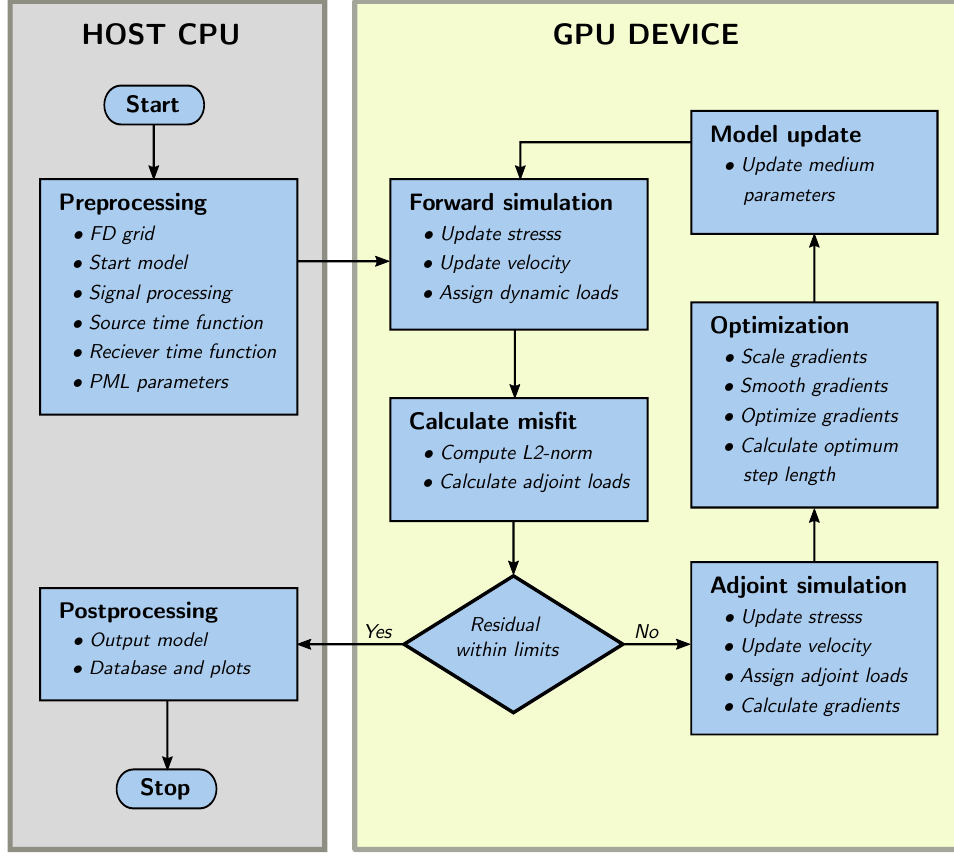
Figure 7. A flow chart of parallel computation of seismic FWI in